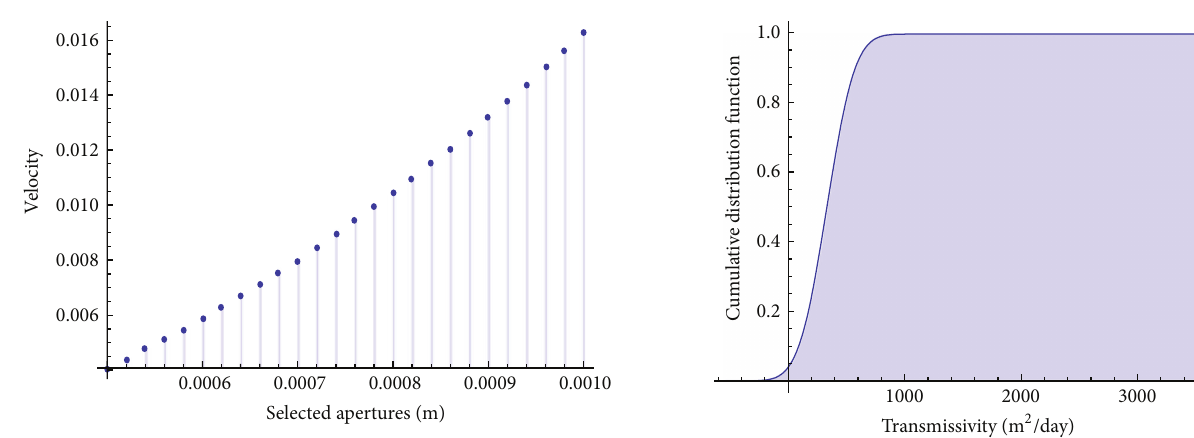
Figure 9: Selected apertures and their associated velocity (m/day).